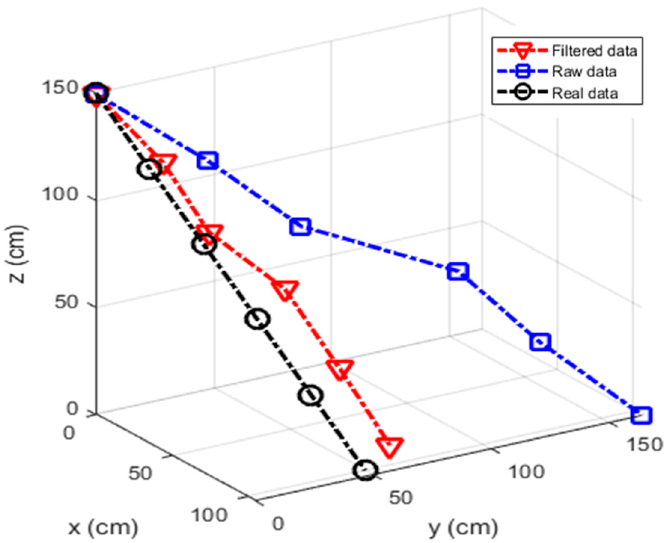
Figure 12. Comparison between estimated (KF) and measured (raw data) landing paths.